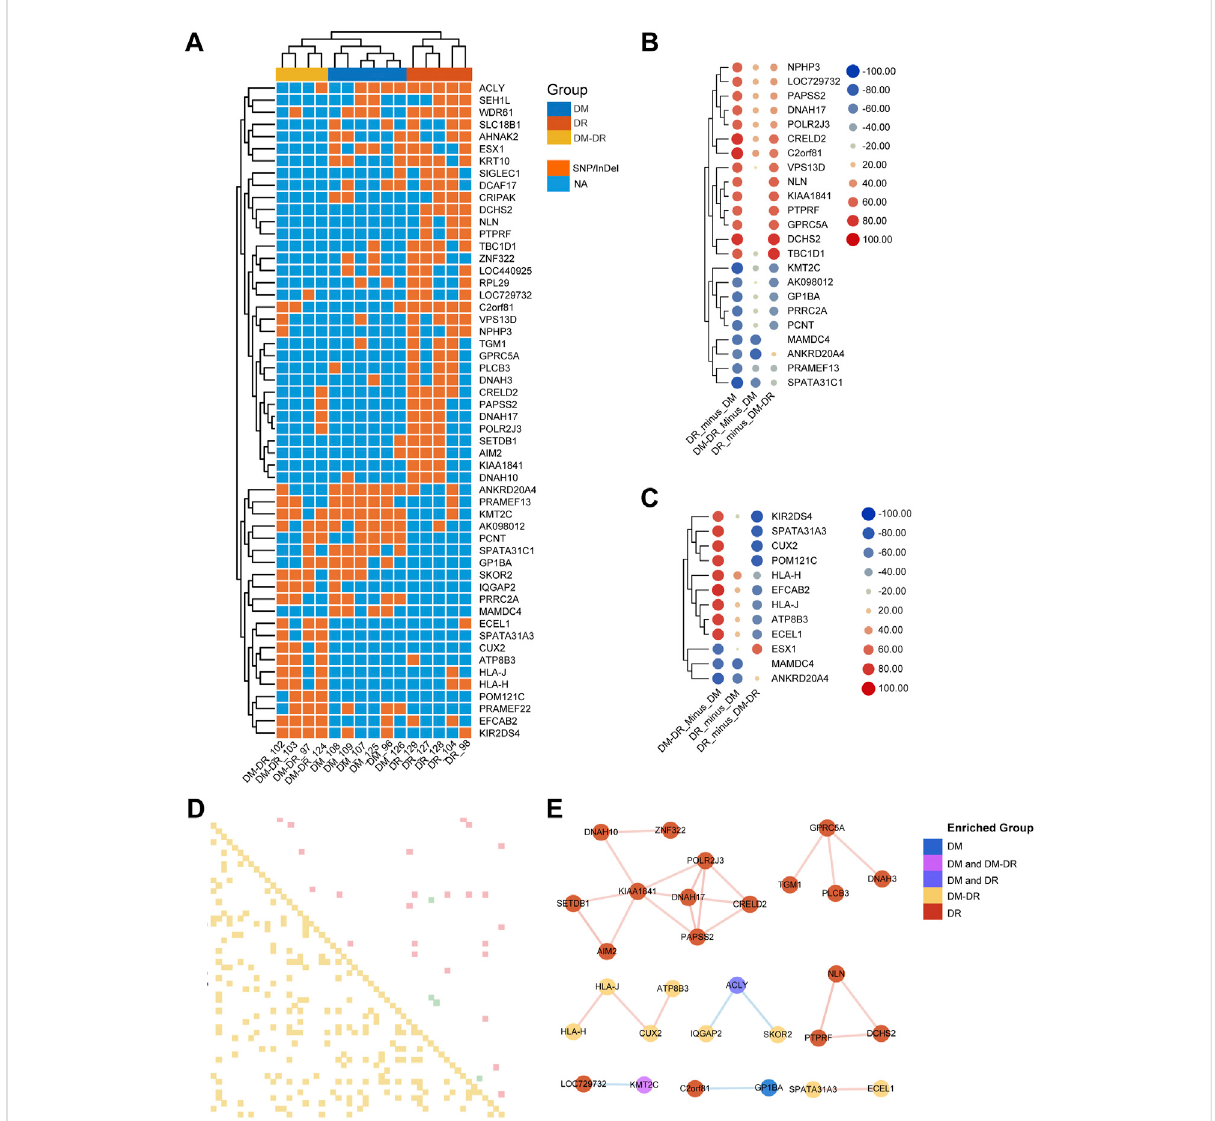
FIGURE 2 Putatively susceptible or protective mutant genes detected across the groups. (A) Heat map-based hierarchical clustering of the 54 putatively pathogenic genes separates these three groups. Under each cluster, samples were sub-grouped by their patients of origin. (B) the 23 signi fi cant differentially mutant genes (DMGs) between diabetic retinopathy (DR) and non-DR (DM) groups. (C) the 12 signi fi cant DMGs between DM – DR and DM groups. The mutation signi fi cance cutoff is 60%. (D) Pearson correlation chart of sigDMGs across 15 samples. The upper off-diagonal entry denotes the pairwise correlation level (red box represents correlation score ≥ 0.8, green ≤ − 0.8) and lower off-diagonal denotes the corresponding p -values (yellow box represents p -value < 0.05). (E) correlation network based on Pearson correlation coef fi cients among these three groups. The red lines indicate positive correlation, and the blue ones indicate negative